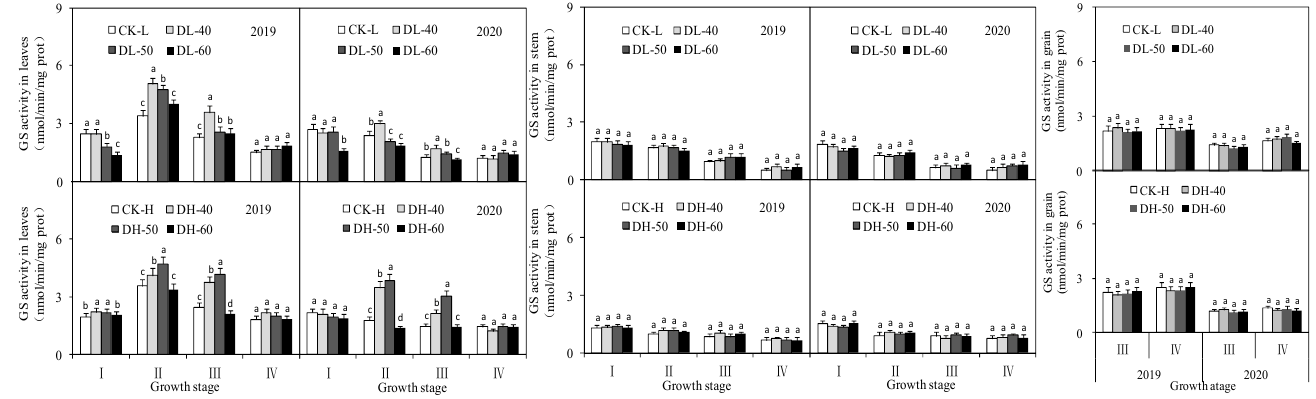
Figure 6. Effects of density and fertilization on GPT activity in organs of forage maize. Note: Different letters on bars indicate significant differences among treatments at the 0.05 probability level.